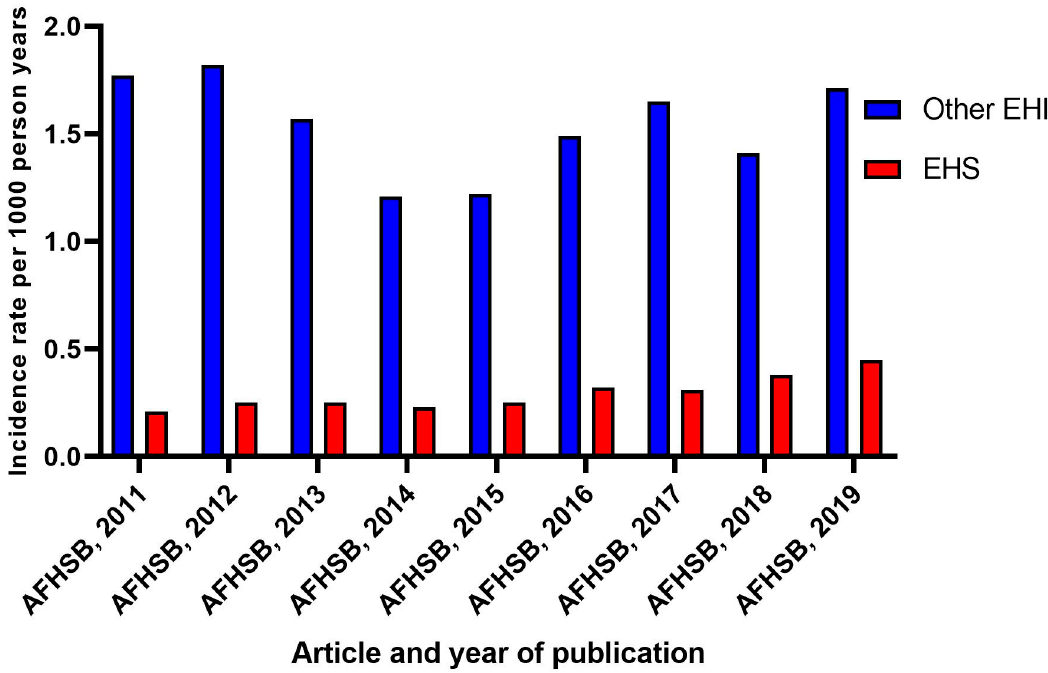
Figure 3. Incidence of exertional heat stroke and other exertional heat illnesses between 2011 and 2019 from the Armed Forces Health Surveillance Branch (AFHSB).